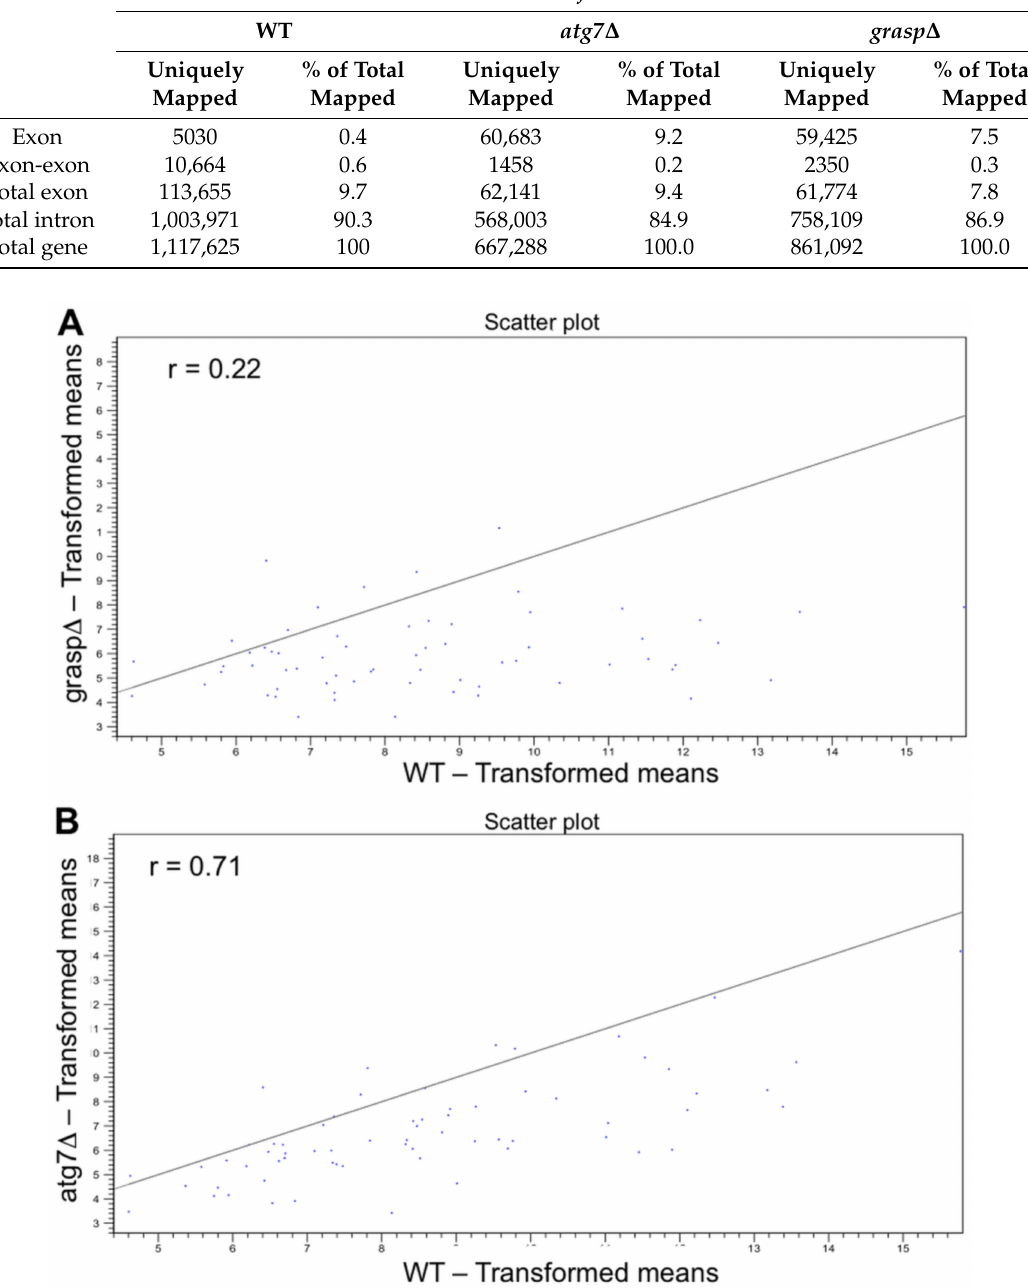
Figure 2. Correlation between the EV-mRNA sequences of grasp ∆ vs. WT samples ( A ) and atg7 ∆ vs. WT preparations ( B ). The transformed mean read values for WT EVs are in the X-axis, while those obtained from mutant vesicles are in the y